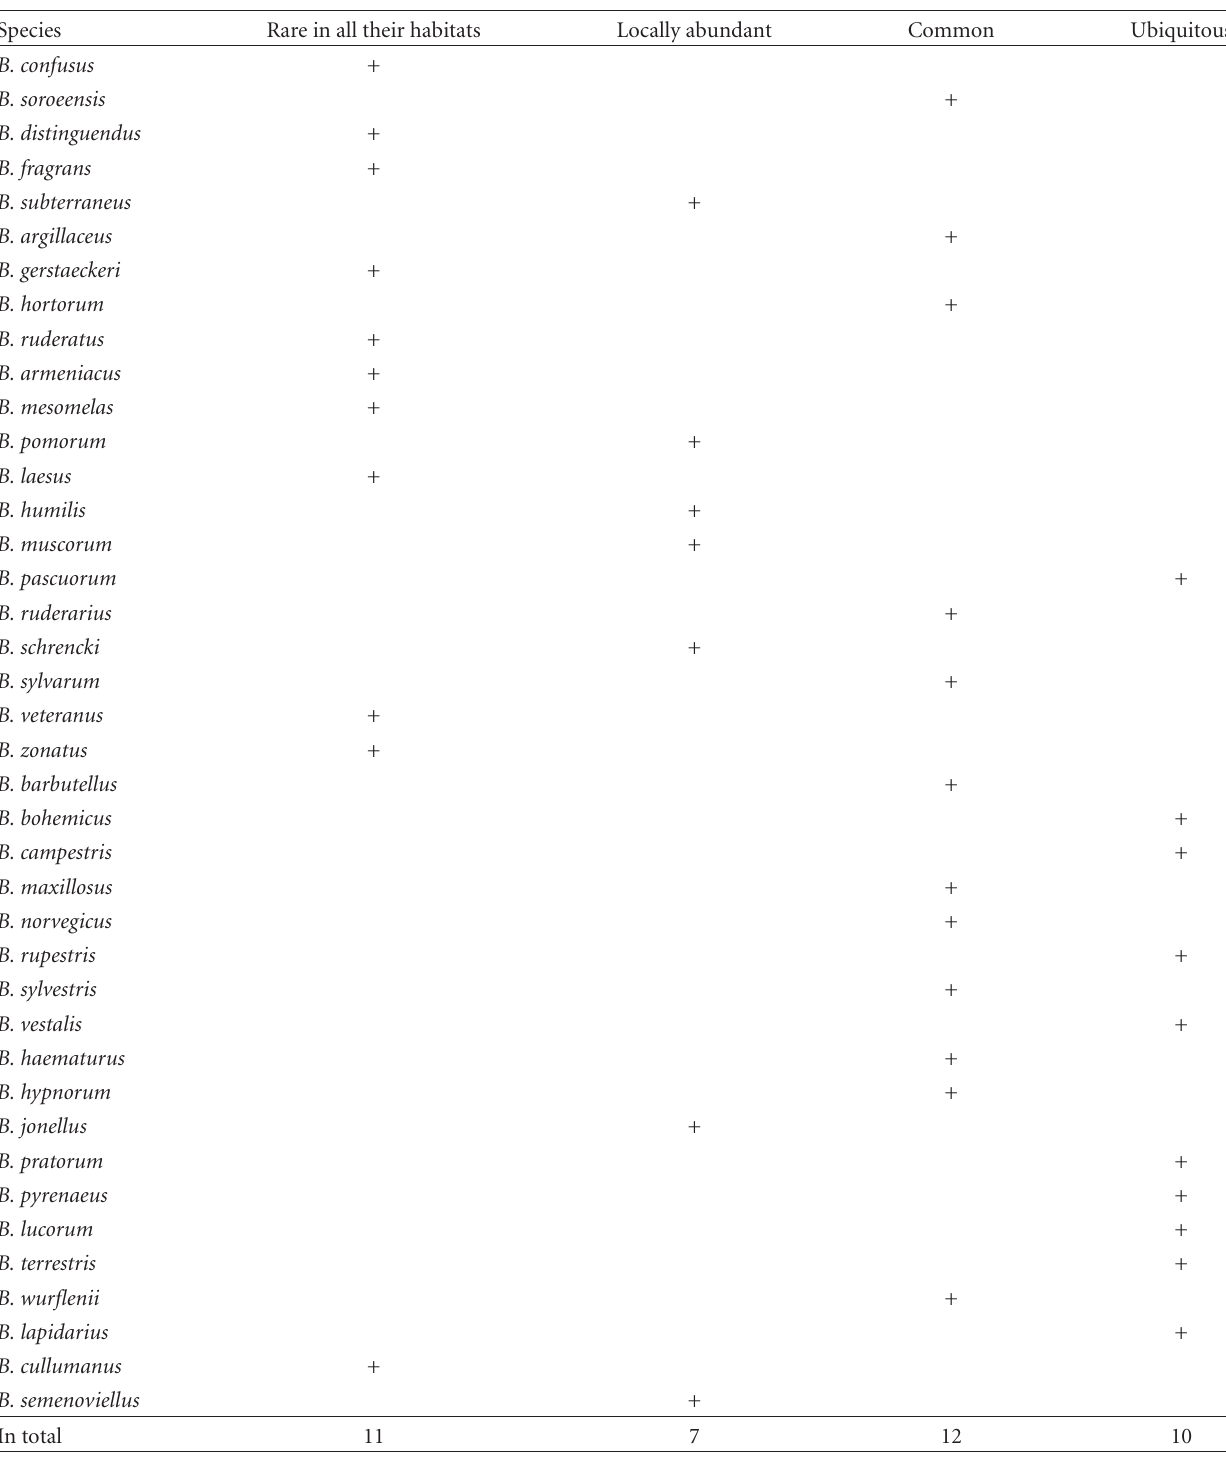
Table 2: Abundance of bumble bee species within their distributional ranges.